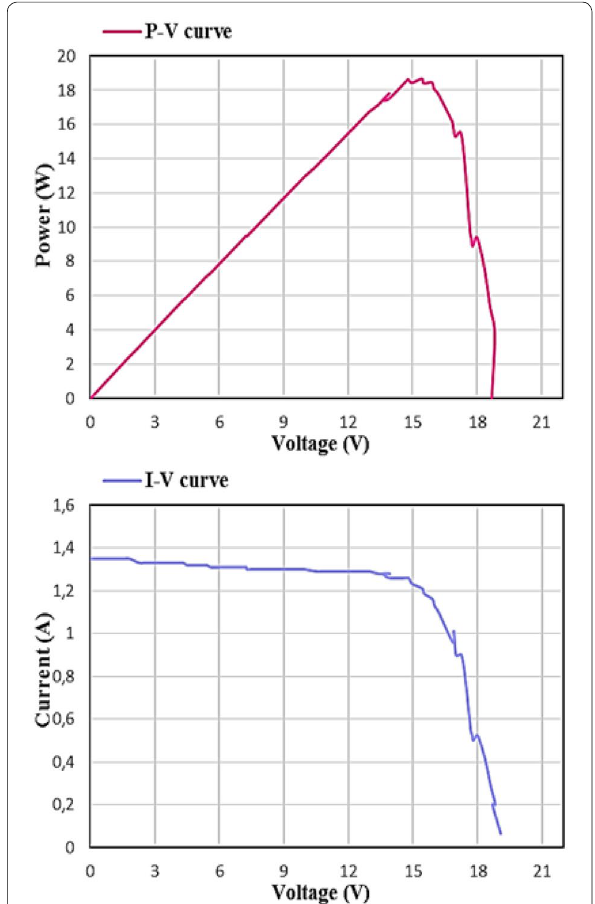
Fig. 16 I – V and P – V characteristics for PV panel by using multimeters (at T 72 °C and G 1100 W/m 2 ) = =